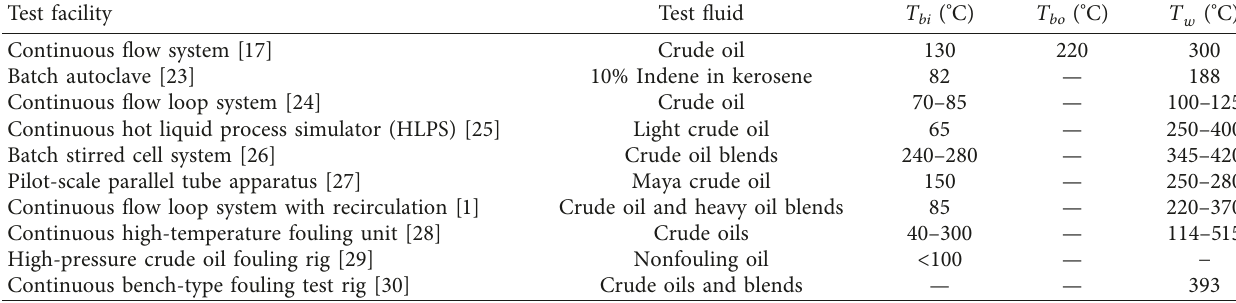
Table 1: Summary of important experimental investigations conducted on fouling.